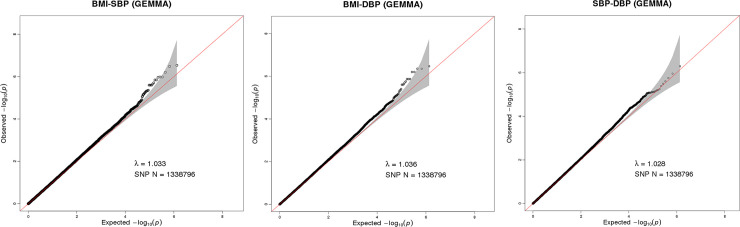
Q-Q plot for SNP associations with BMI-SBP (A), BMI-DBP (B), and SBP-DBP (C). The red line represents the expected value under the null distribution. The x- axis shows the expected -log10 P-values, while y-axis shows the observed -log10 P-values. The gray shaded gives the 95% acceptance region. N refers to the number of SNPs. λ refers to genomic inflation.